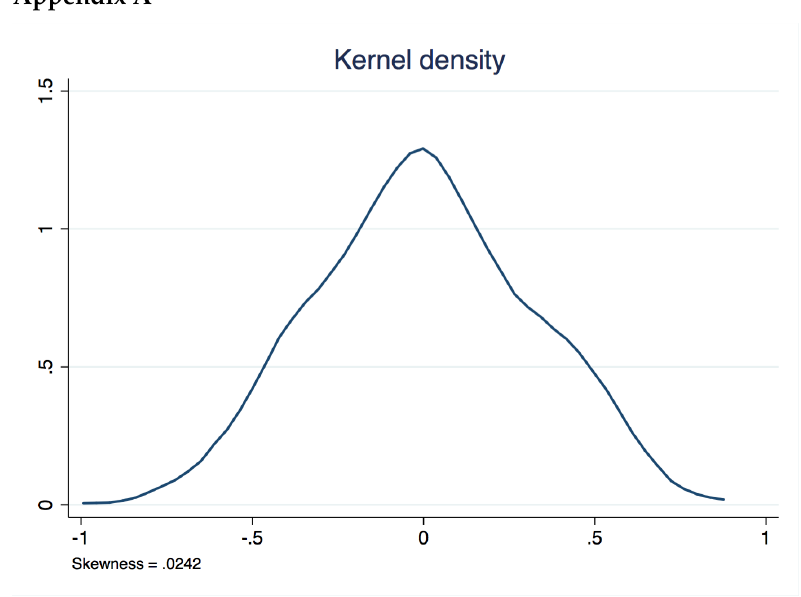
Figure A1. Kernel density of the OLS residuals and